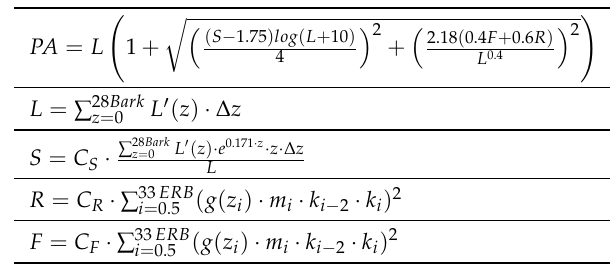
Table 1. Numerical expressions for PA , L , S , R , and F